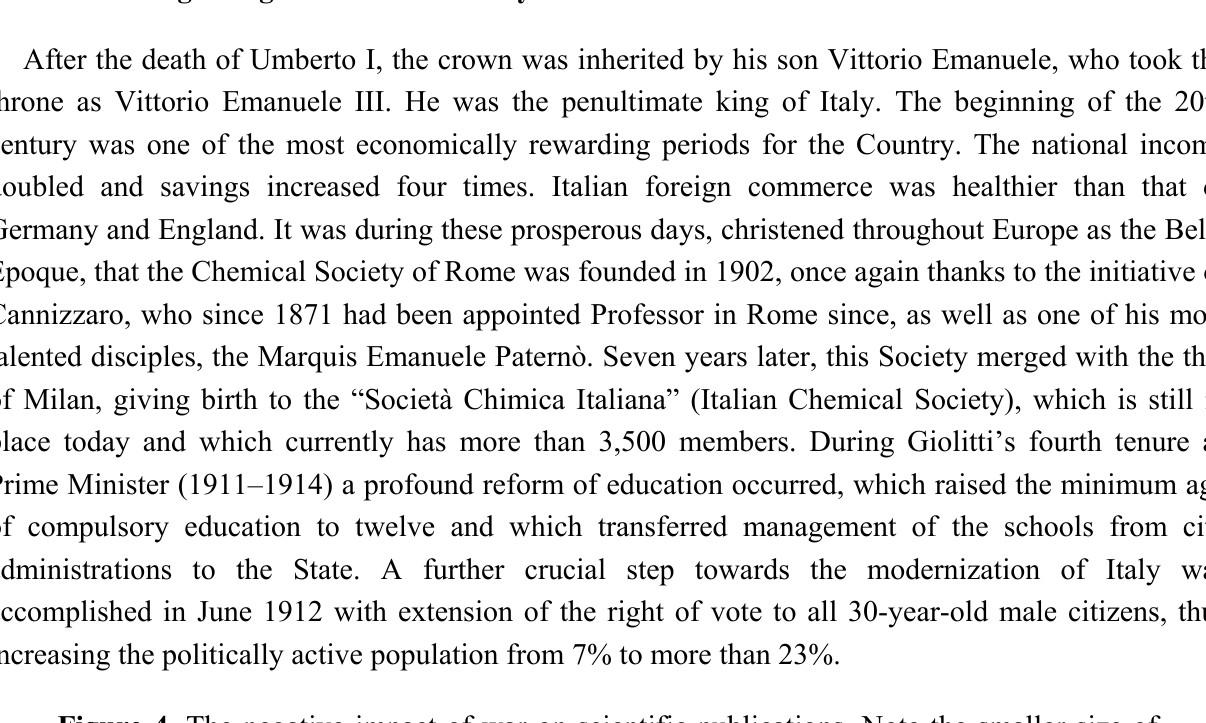
Figure 4. The negative impact of war on scientific publications. Note the smaller size of the Gazzetta Chimica Italiana volumes between 1916 and 1919 (top) and between 1942 and 1945 (bottom) (from the Nerviano Medical Sciences